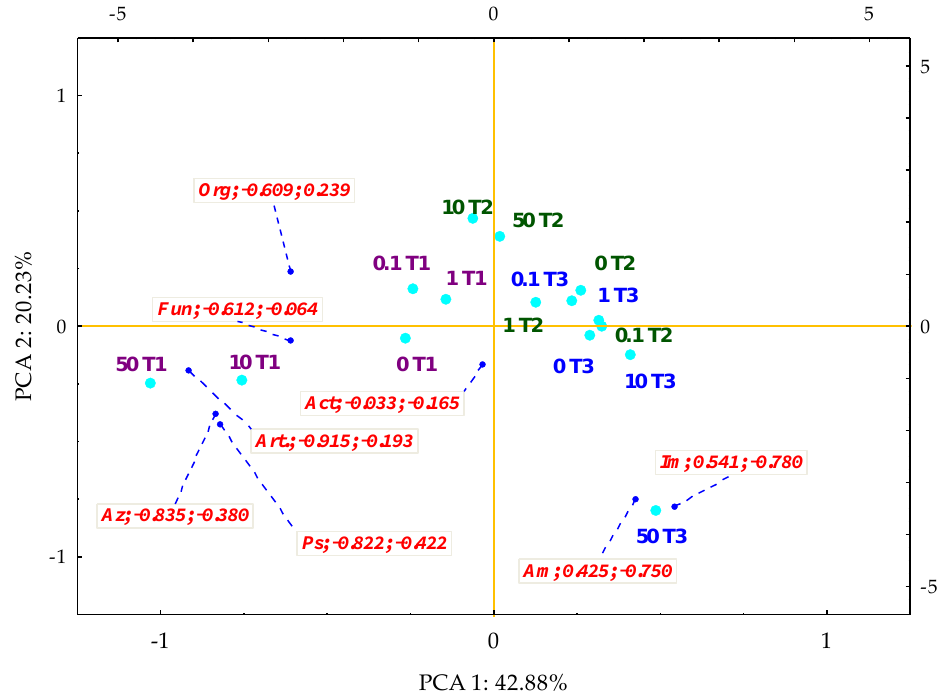
Figure 5. Coefficients of impact (IF Pc ) of Perna canaliculus on the number of microorganisms in